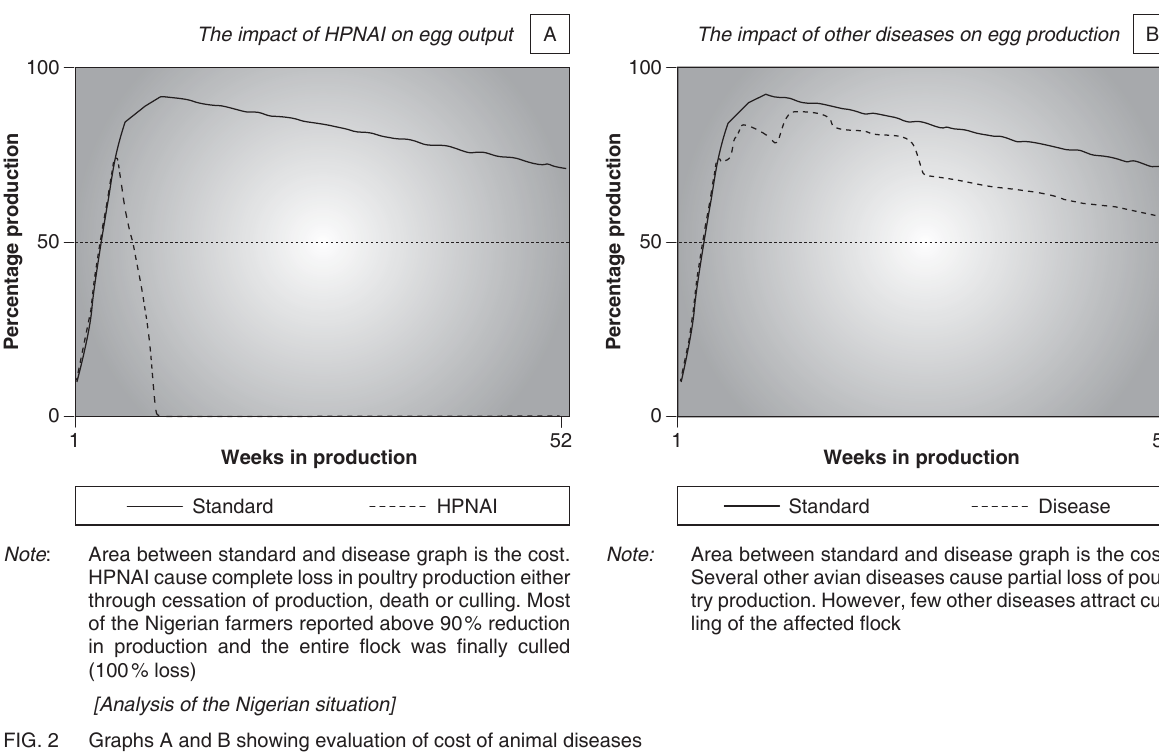
FIG. 1 Importance of cost of animal disease outbreak